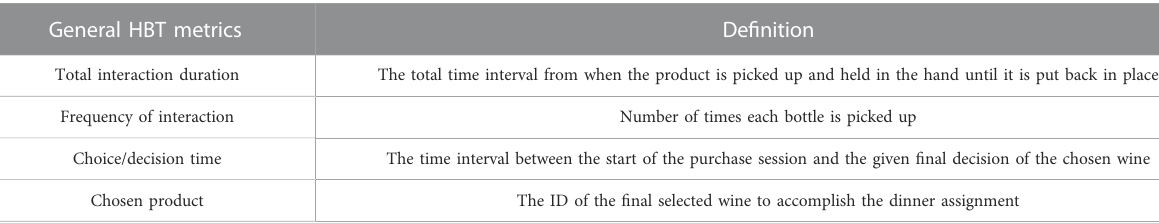
TABLE 2 General HBT metrics of interest are collected during the purchase experience. General HBT